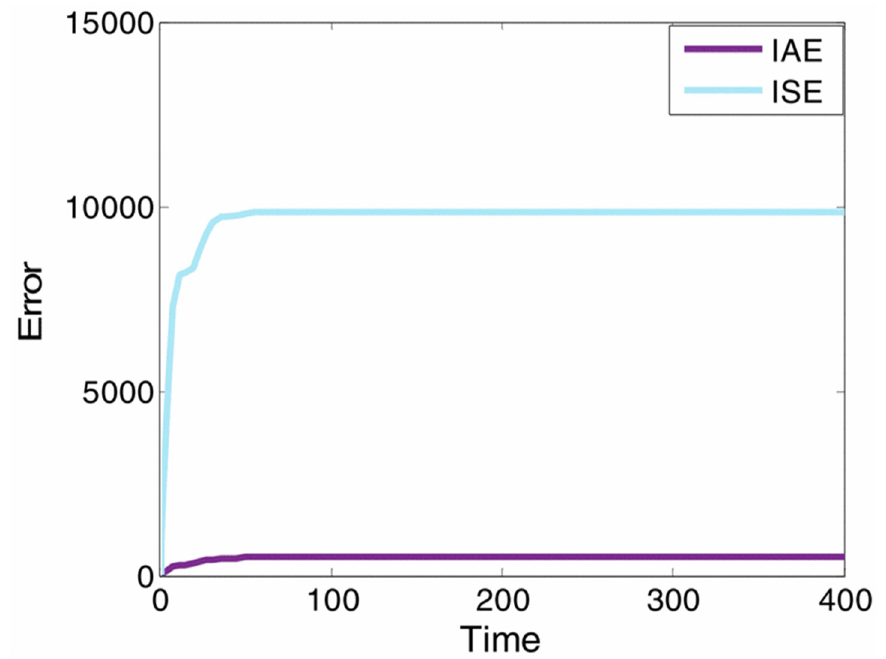
Figure 12. Ambulance error response plot comparison with PSO, along with PID .